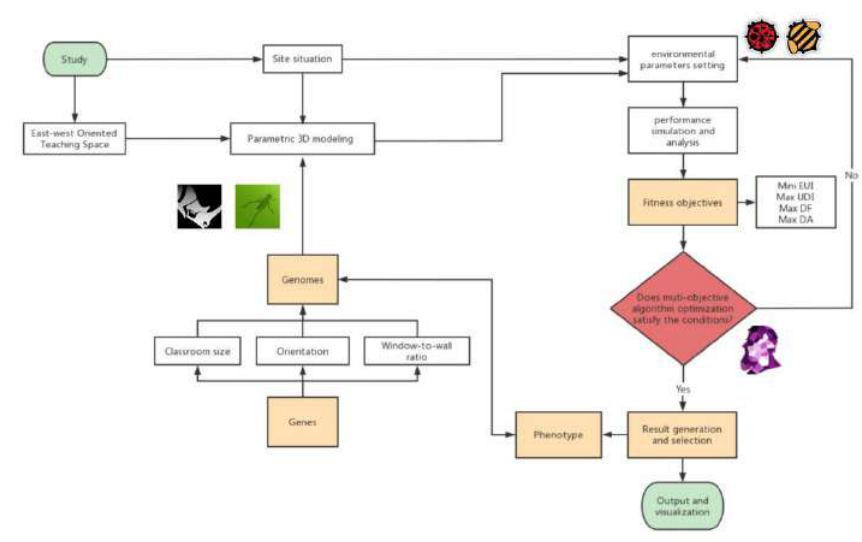
Figure 3. Optimized workflow for east – west-oriented teaching space.